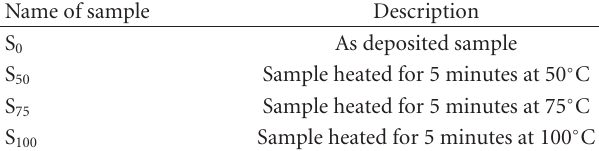
Table 1: Description of samples.